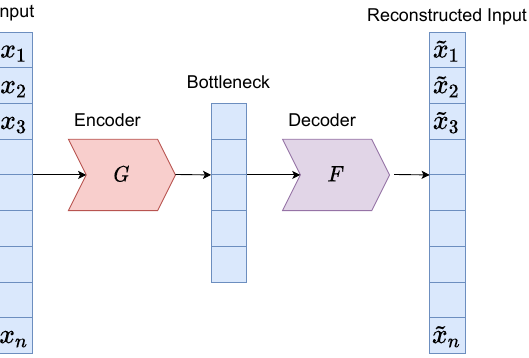
Figure 6. Autoencoder architecture: the output ˜ x is the reconstructed input where a bottleneck enables computing a latent representation of the original input x . x is a vector consisting of n elements from x 1 to x n